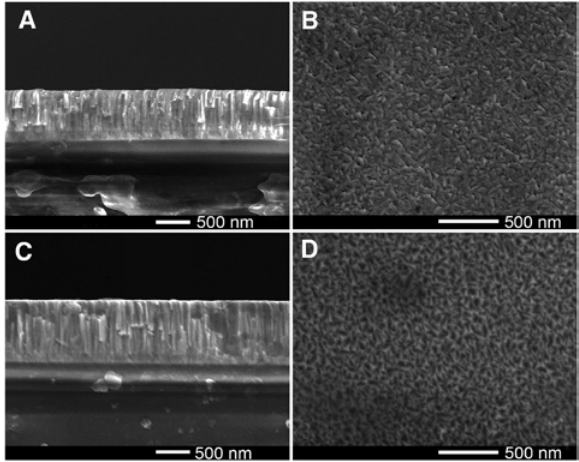
Figure 1: FE-SEM cross-section and surface images of single-layer Mo films deposited by DC-magnetron sputtering at different working pressures of 2 (A, B) and 5 mTorr (C,